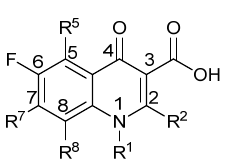
Figure 1. The basic structure of the fluoroquinolones.